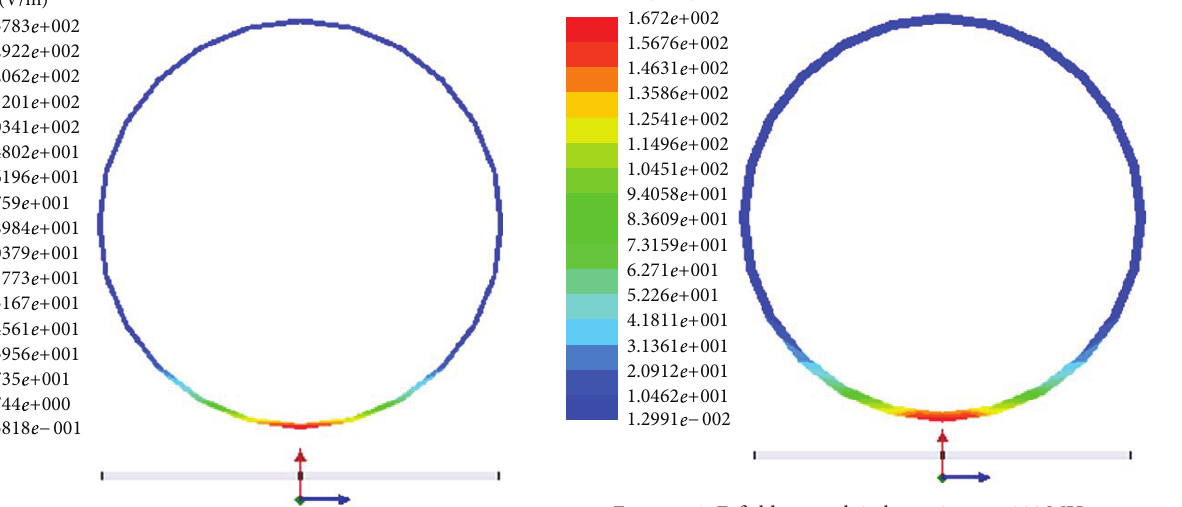
F 11: �-�eld strength in bone tissue at